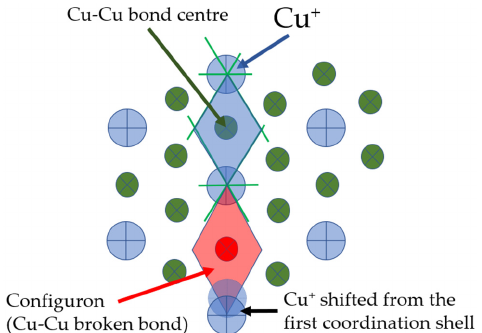
Figure 2. Schematic of a configuron shown by its Voronoi polyhedron shadowed in red colour in amorphous Cu. Formation of configuron is linked to the displacement of Cu + from the first coordination shell [16,18] and local atomic connectivity change by losing a nearest neighbour [23].